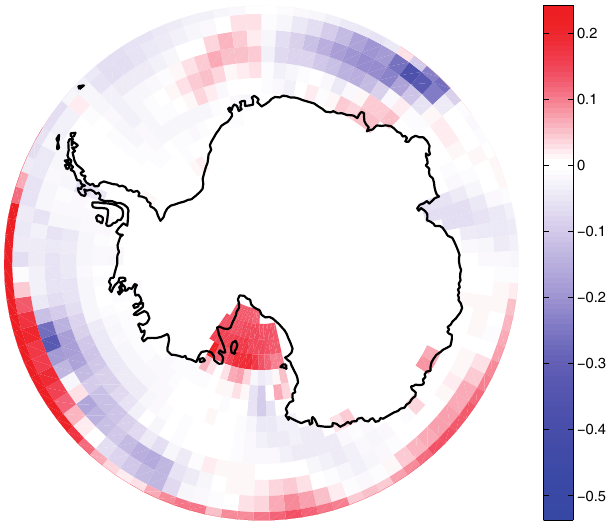
Fig. 6. Eemian minus late Holocene depth averaged ocean temper- atures ( ◦ C) , from 130m to 750m depth. Red: warmer Eemian, blue: warmer modern. Note the asymmetry of the color bar towards colder values (white is centered on 0 ◦